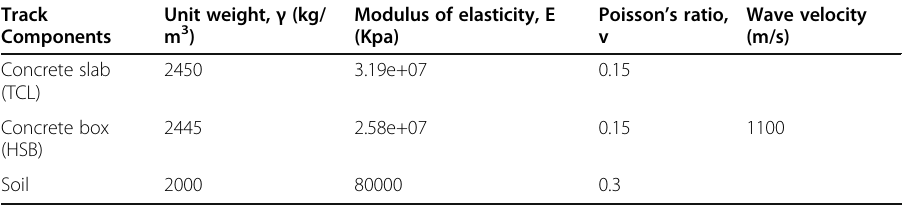
Table 2 Material properties of the railway track model components used for FEA using ABAQUS Track Components